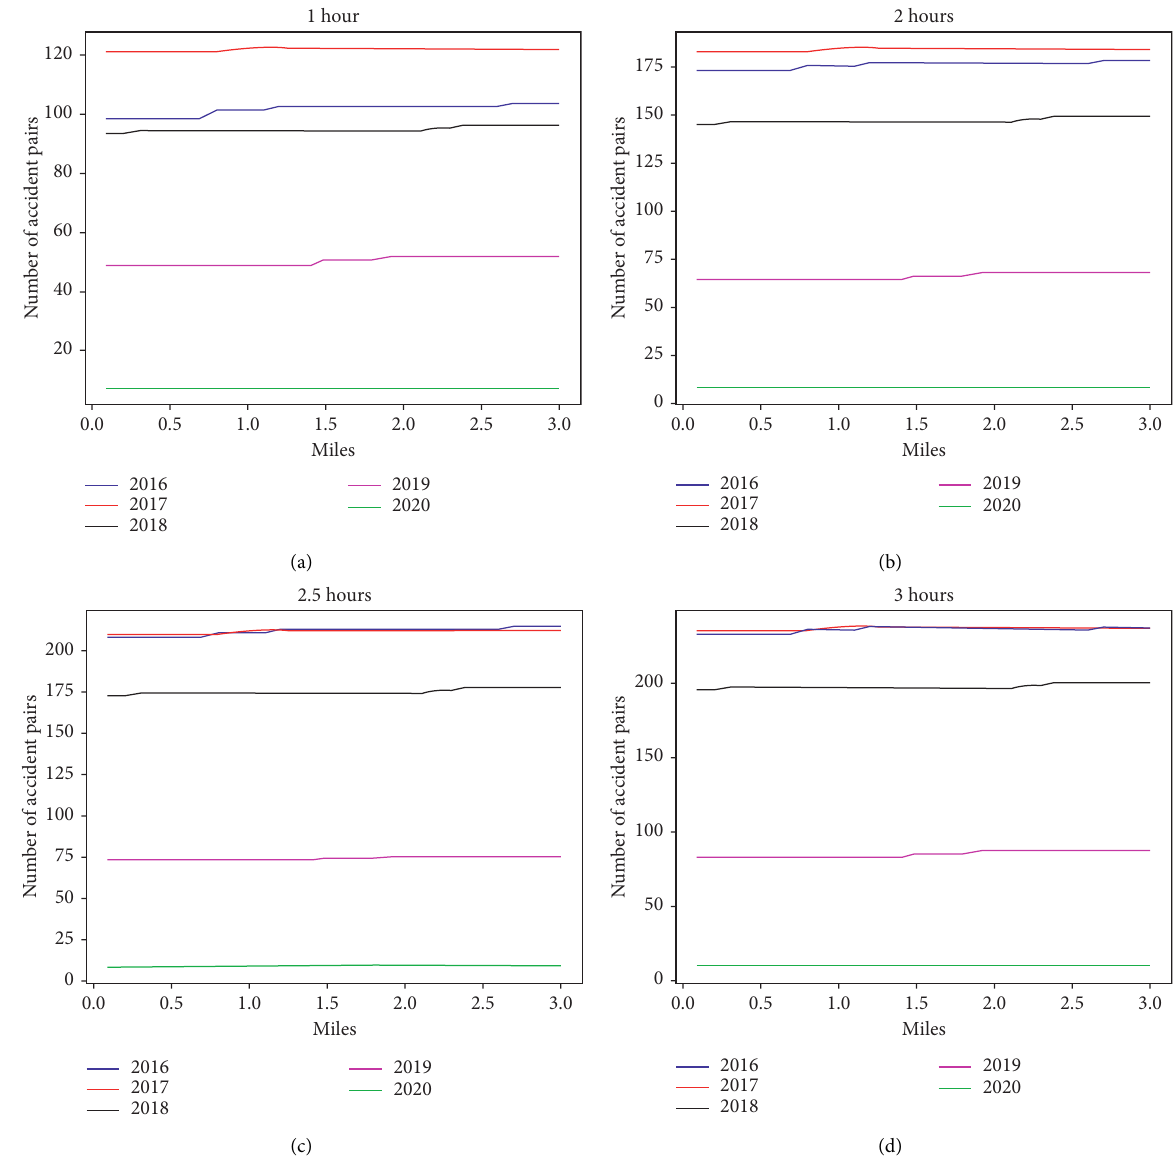
Figure 4: Space threshold sensitivity